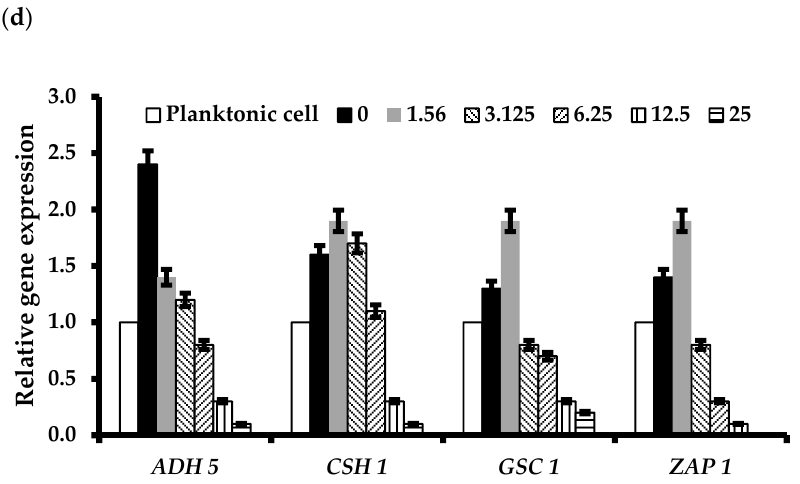
Figure 7. A. triphylla var. japonica extract inhibited the expression of genes involved in biofilm formation and toxicity of C. albicans. A. triphylla var. japonica extract reduced the expression of genes related to ( a ) biofilm formation, ( b ) Ras1-cAMP-Efg1 pathway, ( c ) hyphae-specific, and ( d ) extracellular matrix. Total RNA was extracted from C. albicans treated with the indicated concentration of A. triphylla var. japonica extract using an RNA extraction kit, converted to cDNA, and analyzed by qPCR using each primer. Experiments were performed in triplicate.